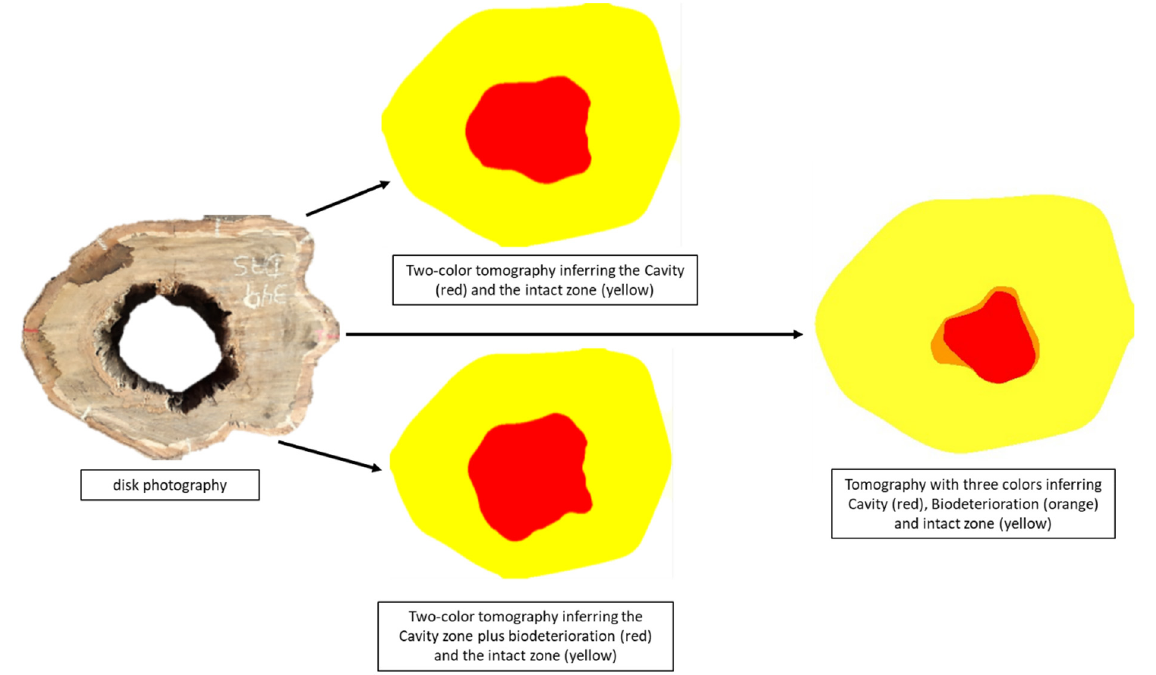
Figure 14. Example of the process with disc photography, tomographic images produced with two colors and cutting velocity for Ca inference (up to 40%) and for Ca+Bio inference (up to 45%) and tomographic image with three colors separating Ca from Ca+Bio.